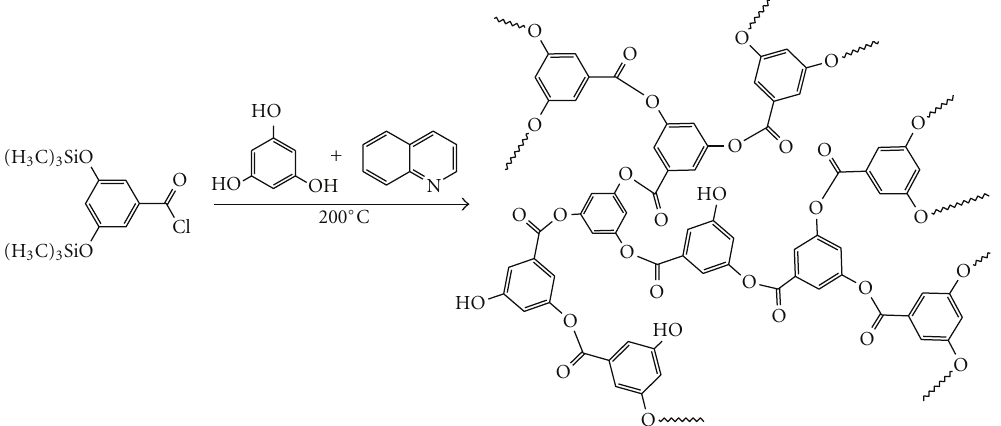
Scheme 3: Synthesis of hyperbranched aromatic